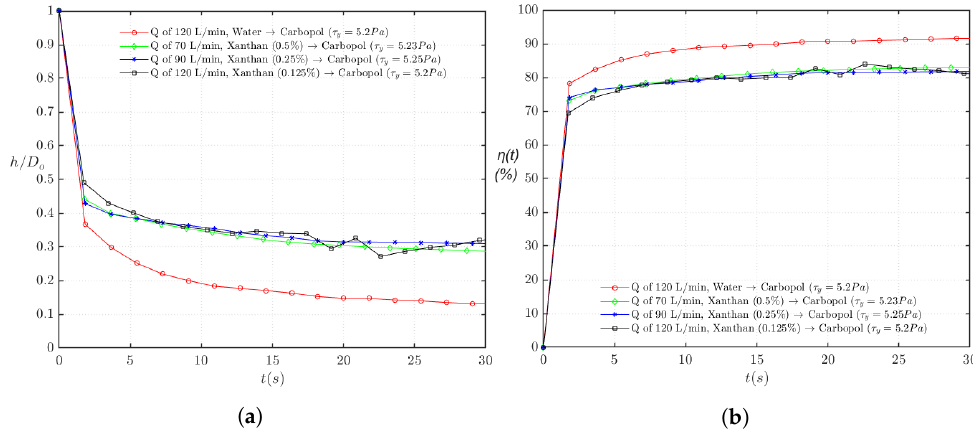
Figure 13. Displacement performance: ( a ) Average measured thickness of the Carbopol layer in an imposed pressure drop condition and ( b ) computed volumetric efficiency in an imposed pressure drop condition.